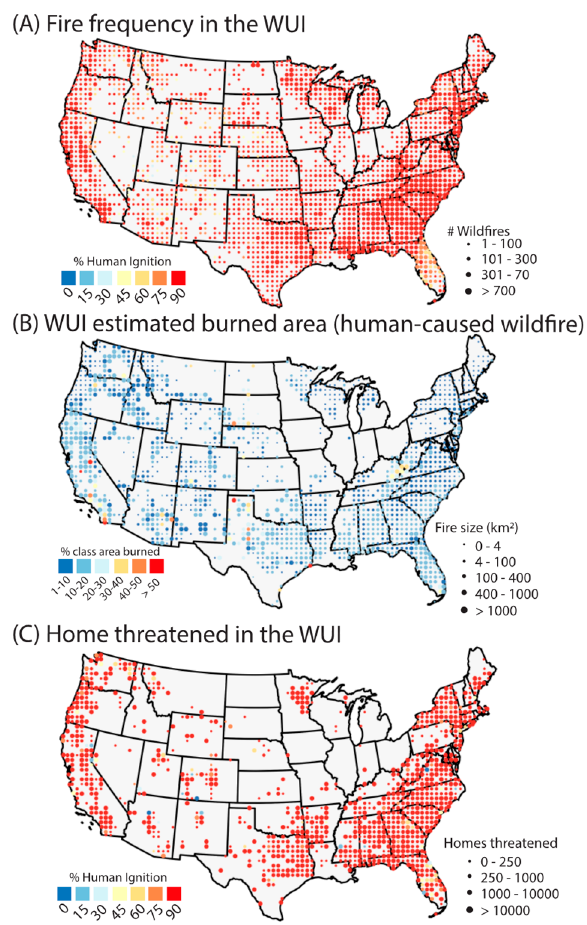
Figure 1. ( a ) The total number of wildfires (dot size) that originated in the wildland-urban interface stratified by the proportion of wildfires caused by humans, ( b ) the total fire size (dot size) as a percentage of WUI that was burned by human-caused wildfires, and ( c ) the total number of homes threatened in the WUI stratified by the proportion of wildfires caused by humans within each 50-km pixel between 1992 and 2015. Black lines represent state boundaries. For ( a , c ), reds indicate a greater proportion of human-caused wildfires, while blue indicates a greater proportion of lightning-caused wildfires. Note, only the buffer estimated burned area was used ( b ), not the 250/500/1000 m buffers.